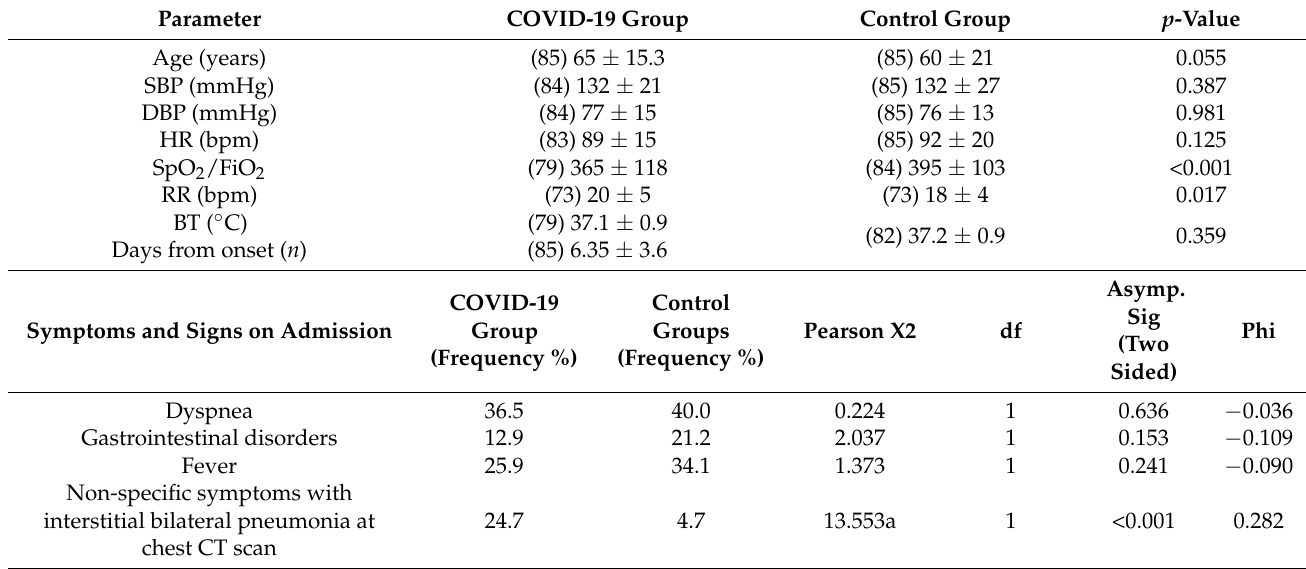
Table 1. Matched analysis between COVID-19 patients and controls and chi-squared test results for the distribution of presenting symptoms. SBP, systolic blood pressure; DBP, diastolic blood pressure; HR, heart rate (beats per minute); SpO 2 /FiO 2 , oxygen saturation level/fraction of inspired oxygen; RR, respiratory rate (breaths per minute); BT, body temperature. All radiological examinations were reported by a radiologist and carried out 24 h from